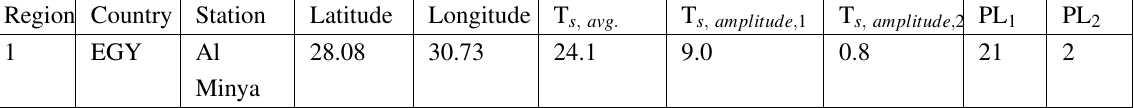
Table 2. Constant values for the Site:GroundDomain:Basement, Xing approach inputs (Xing 2014), p158. Region Country Station